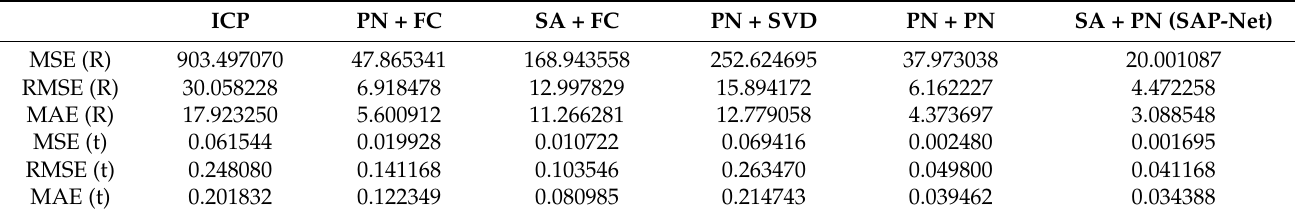
Table 2. Test on full dataset. Various implementation combinations are presented by abbreviations (feature extraction + rigid body